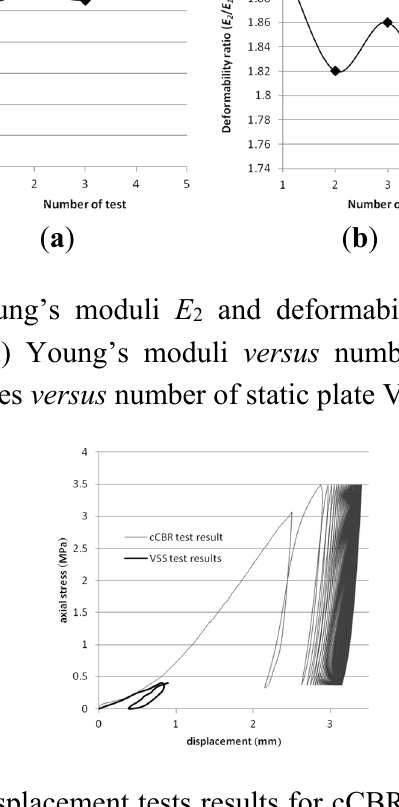
Figure 14. Plot of stress-displacement tests results for cCBR and static load plate VSS on steel slag in duplicate